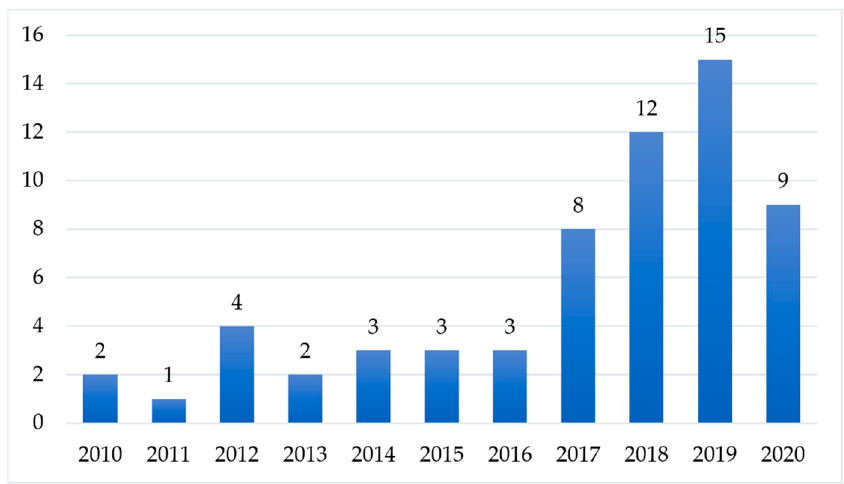
Figure 5. Number of articles distributed per year of publication, from 2010 to November 2020.